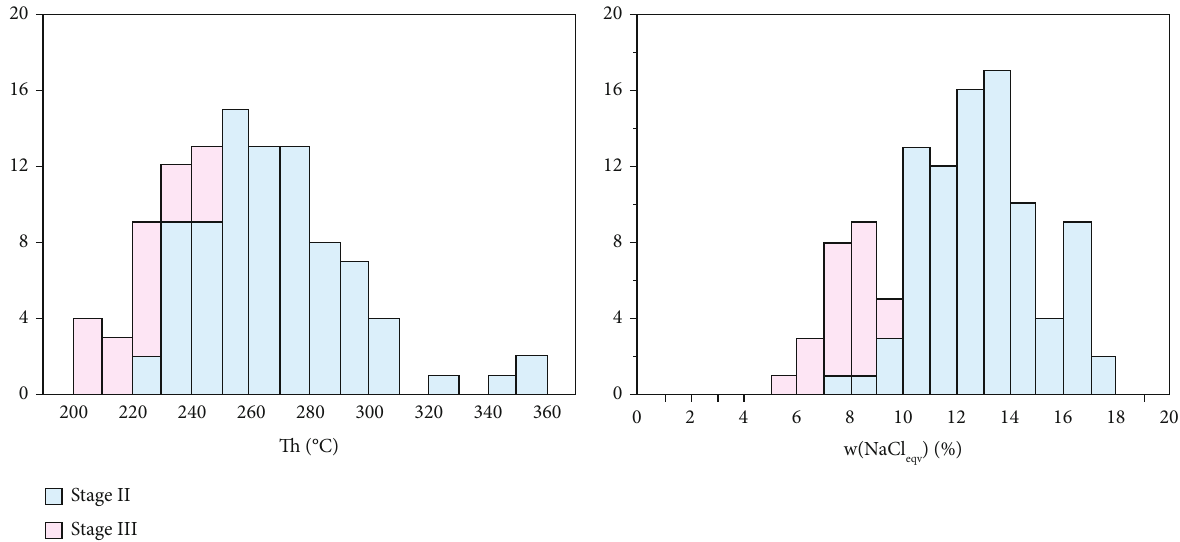
Figure 9: Histograms of homogenization temperatures and salinities of fl uid inclusions in the Tieling Cu-Mo deposit. T homogenization temperature.